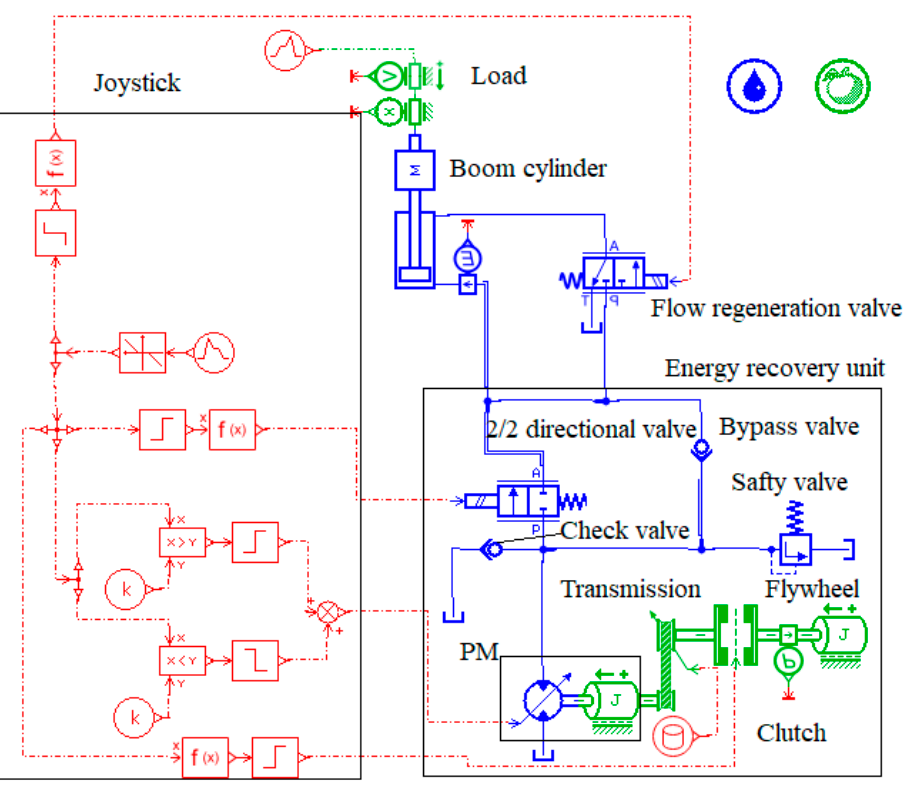
Figure 7. The simulation model established in AMESim software.